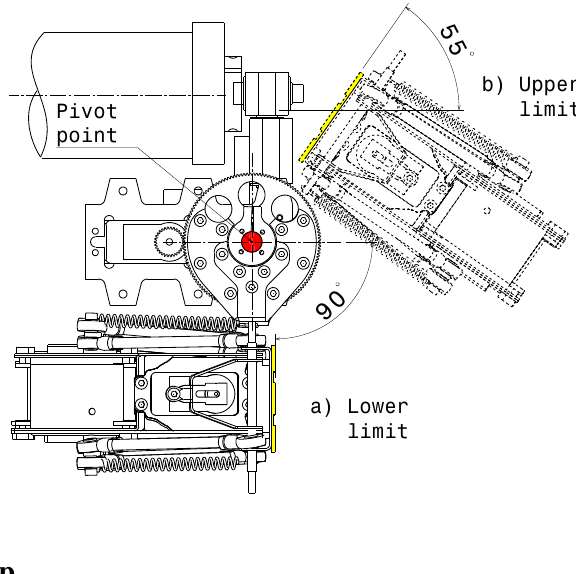
Figure 5. Limits in pitch degree of freedom.